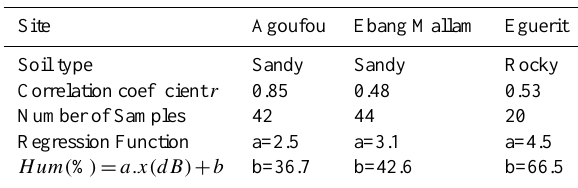
Table 4. Correlation coefficients ( r) between local surface soil moisture and normalized backscattering coefficient at the three con- sidered local sites. Only descending orbit data ( D ) are considered for the rocky Eguerit site.